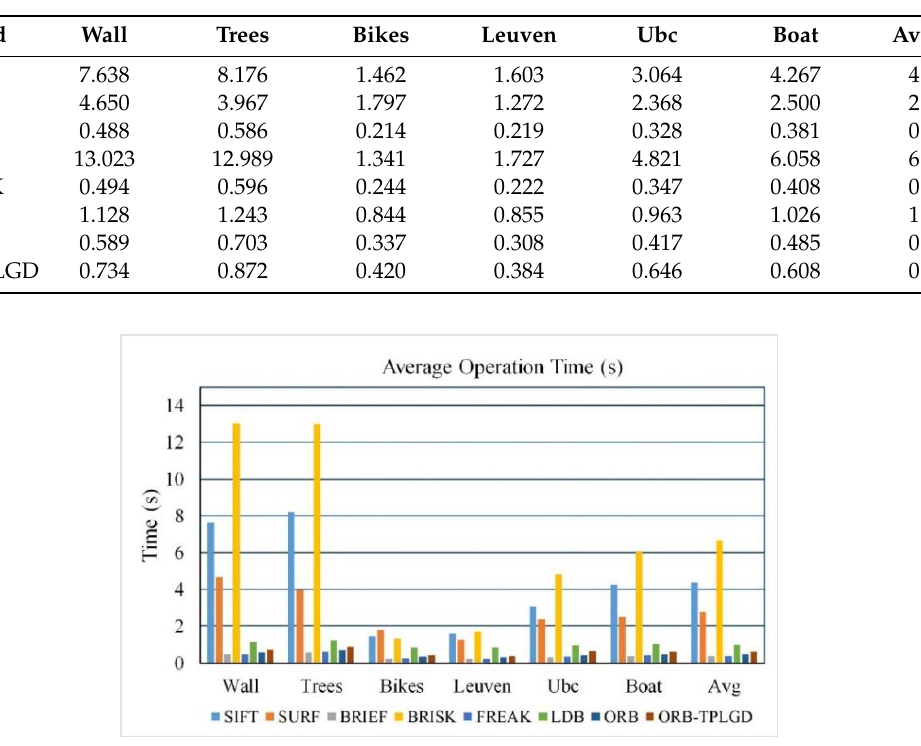
Table 7. Average matching time based on Oxford dataset (s).